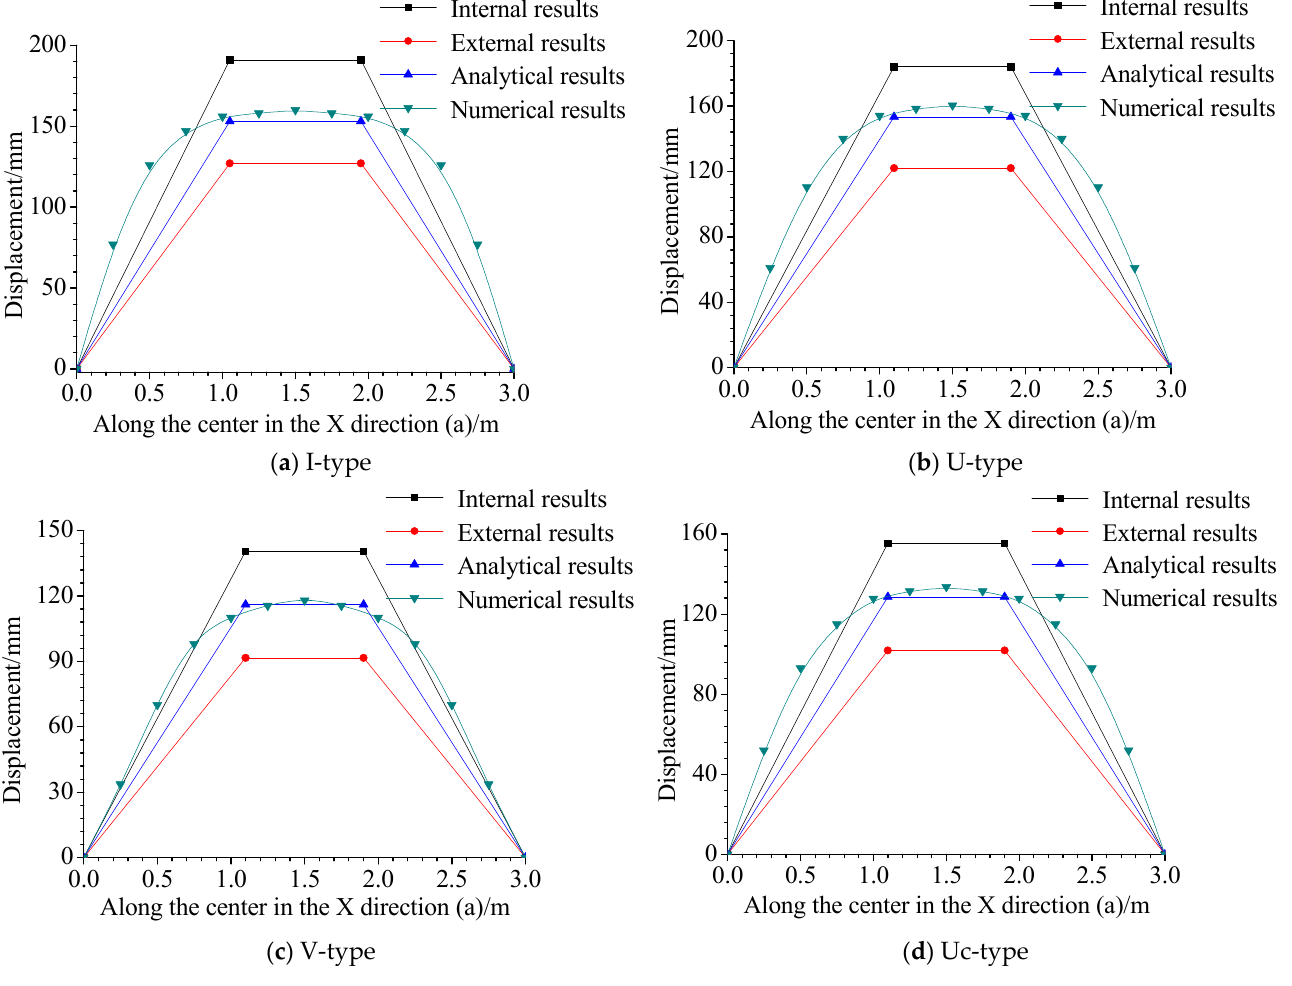
Figure 8. Displacement of the centerline in the long side direction. The trend of the simplified analysis results along the center in the X and Y directions